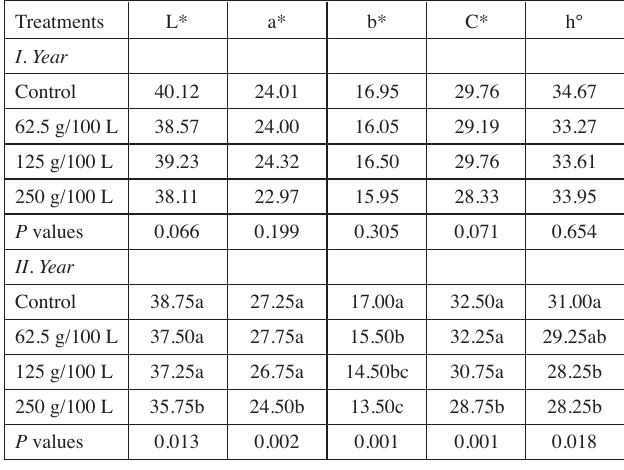
Tab. 4: The effect of Pro-Ca dosage on some fruit color characteristics in the ‘Starcrimson’ apple cultivar